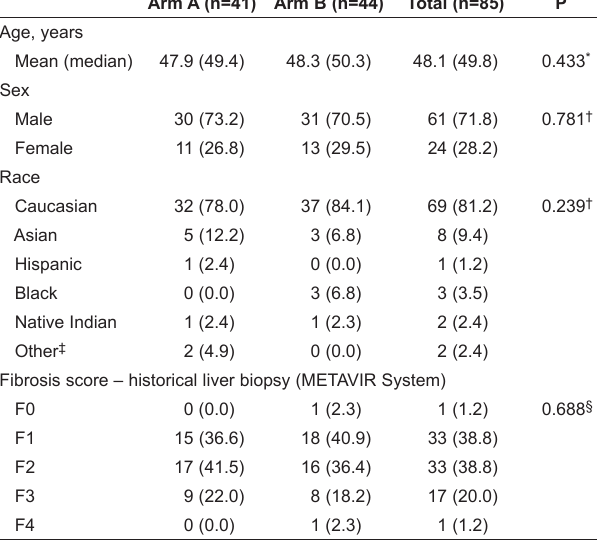
Figure 1) Participant flow diagram. Intent-to-treat (ITT) population defined as all randomized subjects who received at least one dose of study medication (n=85 [89%]; 70% male). Four subjects did not receive any study medication. One patient reported two reasons for discontinuation including adverse event and treatment failure at week 24 in arm B. One patient completed the initial 17 visits but did not return at visit 18 (week 72); this patient was not considered Table 1 Patient demographics according to treatment group –